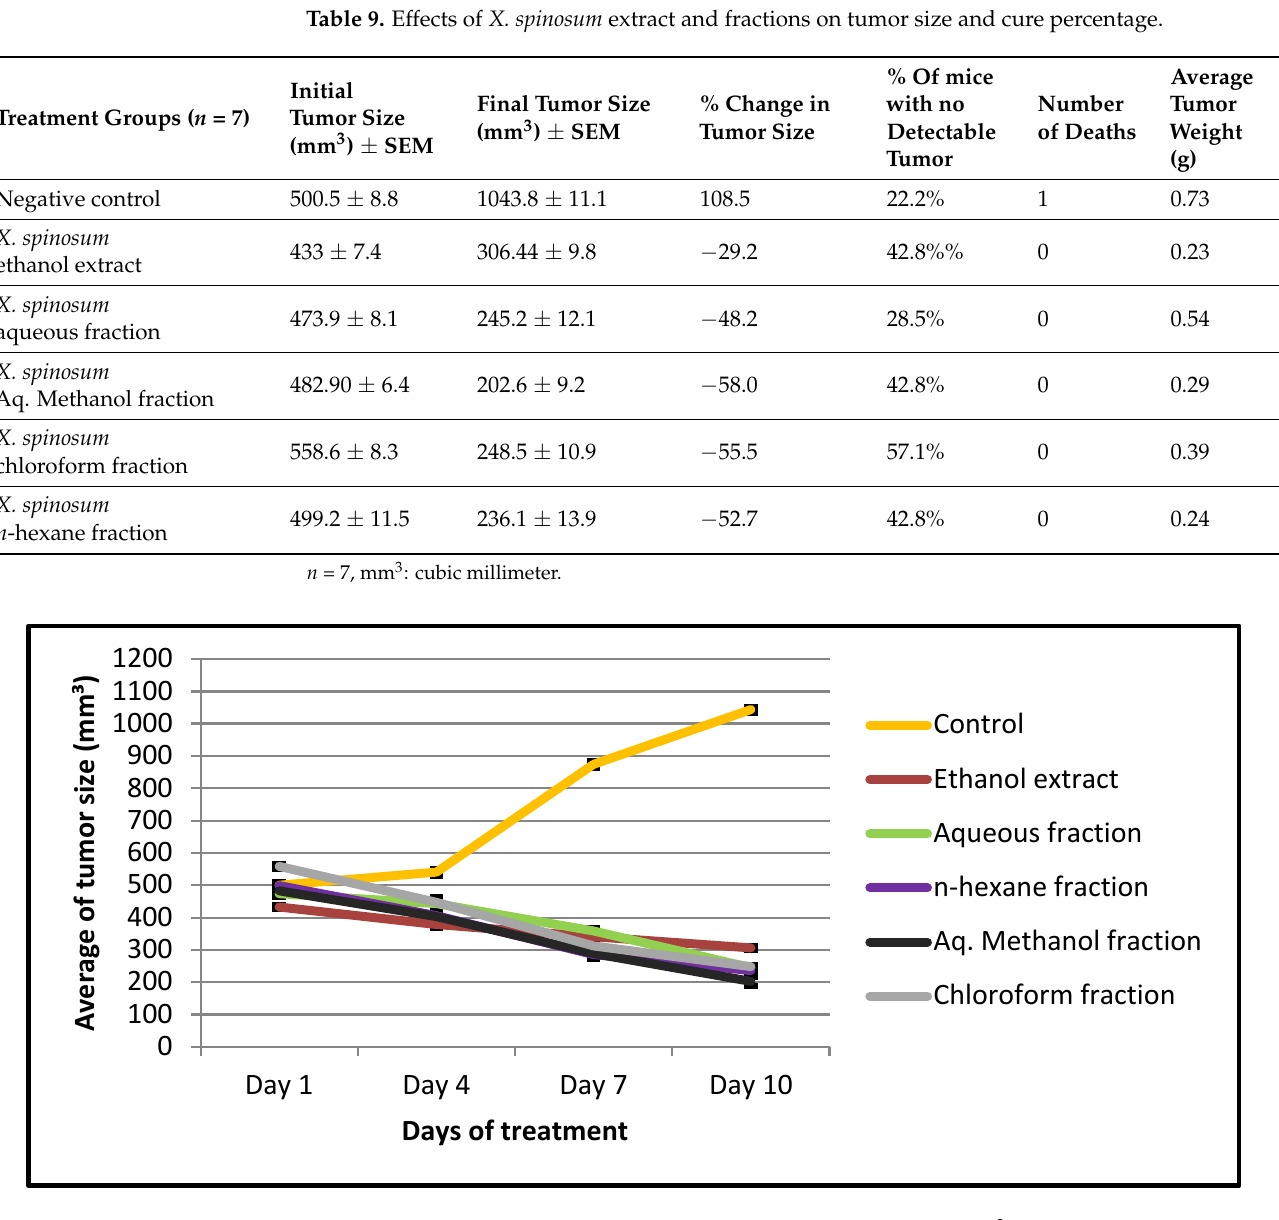
Table 9. Effects of X. spinosum extract and fractions on tumor size and cure percentage.